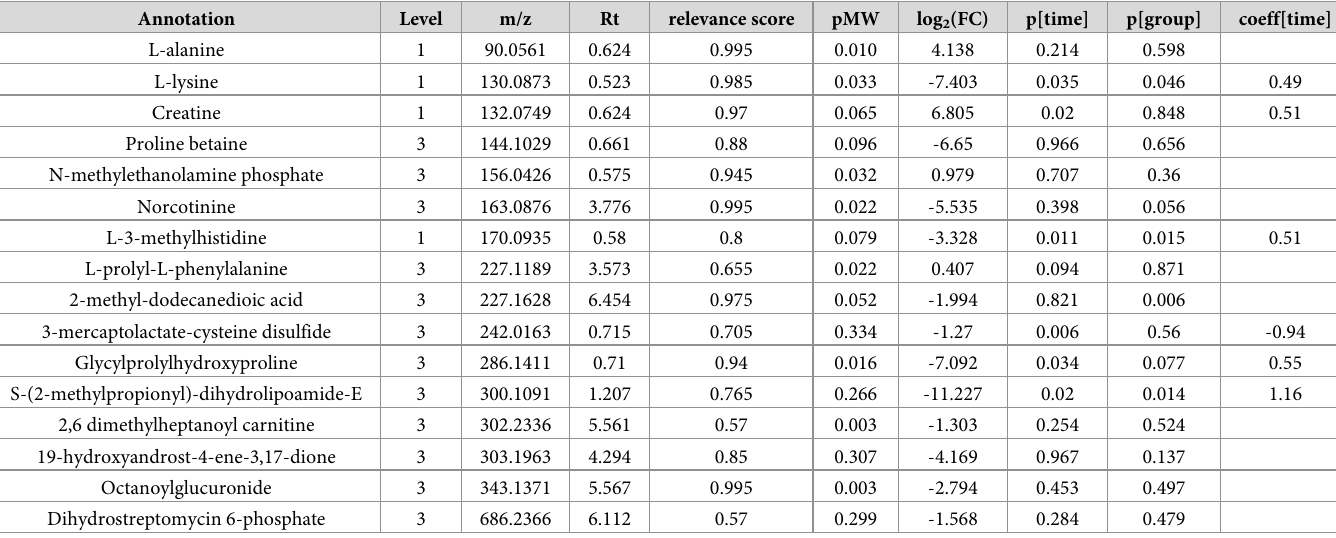
Table 2. Annotated variables of the metabolic signature discovered by PLS for